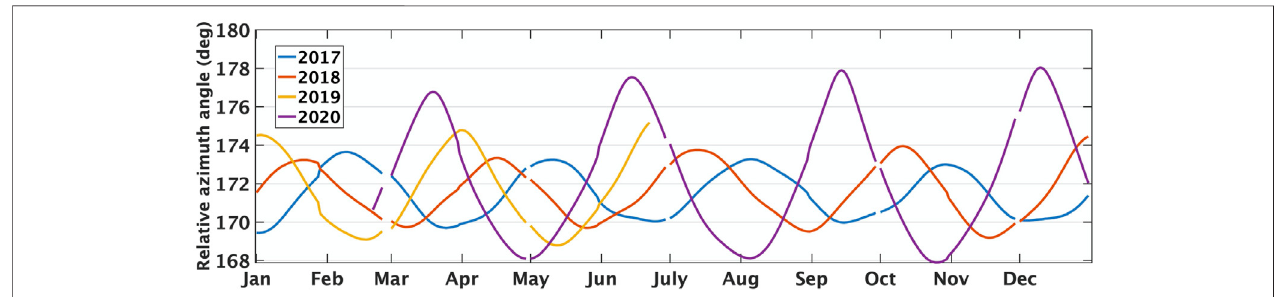
FIGURE 2 | Year-to-year variation of the relative azimuth angle for DSCOVR.